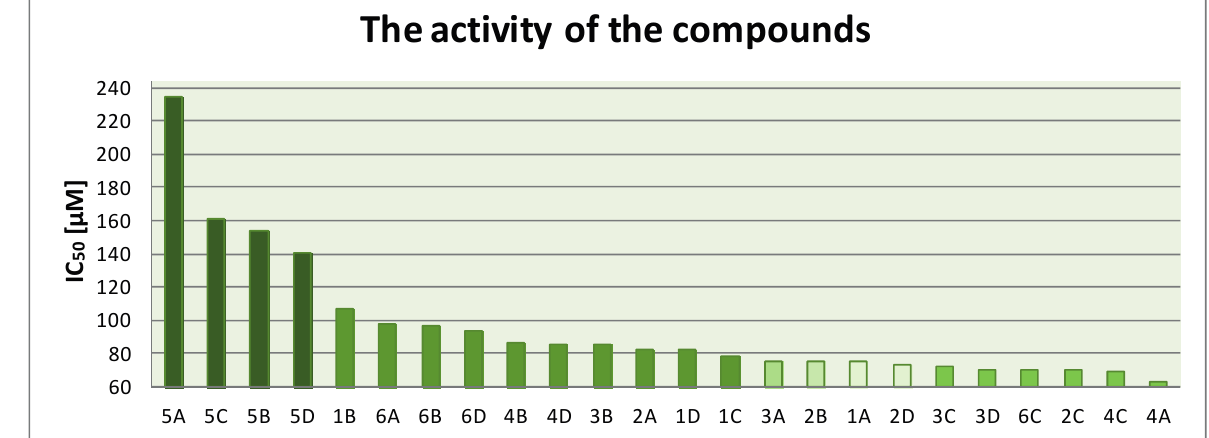
Figure 3. The IC